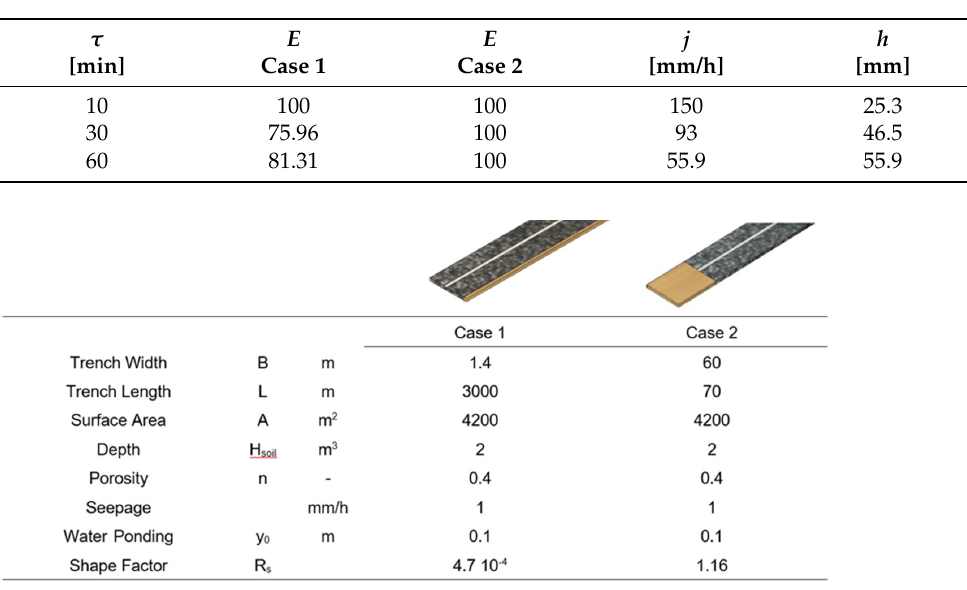
Table 1. Efficiency E (Equation (17)) of the two technical solutions proposed in Figure 2, evaluated for different rainfall intensity and duration with return time RT = 20.